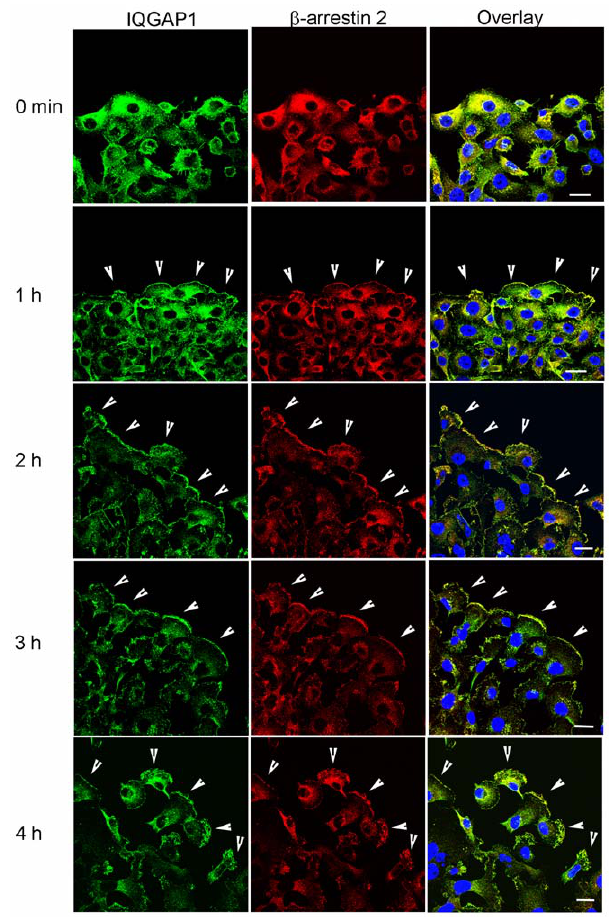
Figure 7. b -Arrestin2 co-localizes with IQGAP1 at the leading edge of migratory breast cancer cells. MDA-MB-231 cells were serum starved for 4h and scratched with a sterile pipette tip. Cells were then placed in serum-free medium containing 10 m M LPA and allowed to migrate into the scratch. Cells were fixed, permeabilized, immuno- stained and visualized using confocal microscopy. Time course of endogenous IQGAP1 immunostaining performed with rabbit anti- IQGAP1 antibody followed by Alexa-Fluor 488 (green). Endogenous b - arrestin2 immunostaining was performed with a polyclonal goat anti- b - arrestin2 antibody followed by Alexa-Fluor 555 (red). Areas of co- localization in lamellipodia at the leading edge of motile (arrows, overlay) is shown in yellow. Scale bar, 20 m m.